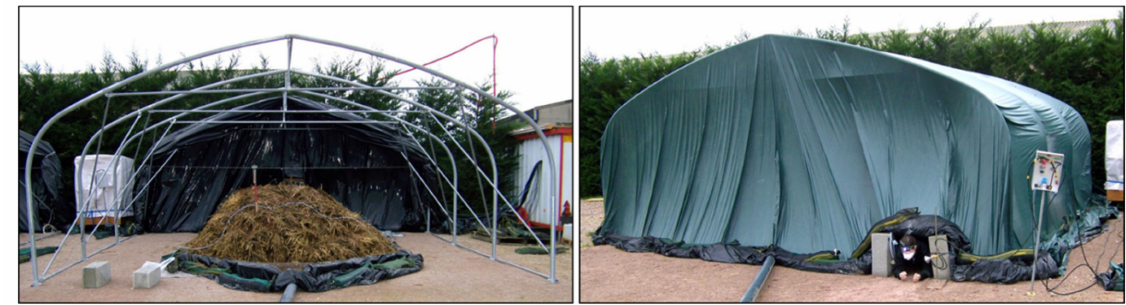
Figure 3. Photographs of the storage greenhouse, uncovered ( left ) and covered ( right